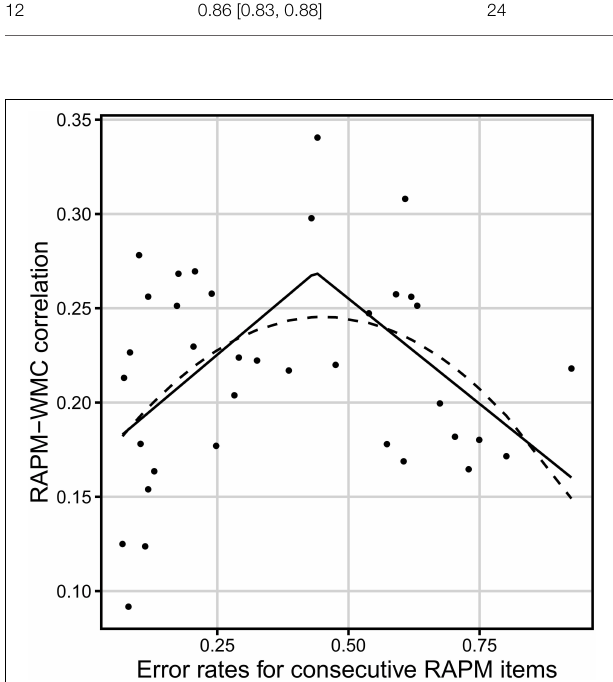
FIGURE 5 | Relation between the dificulty of a Raven-test item (error rate) and the correlation between accuracy on that item and WMC (measured with the complex span tasks). The solid line represents the segmented regression line. The dashed line reflects the quadratic regression line N 347 =